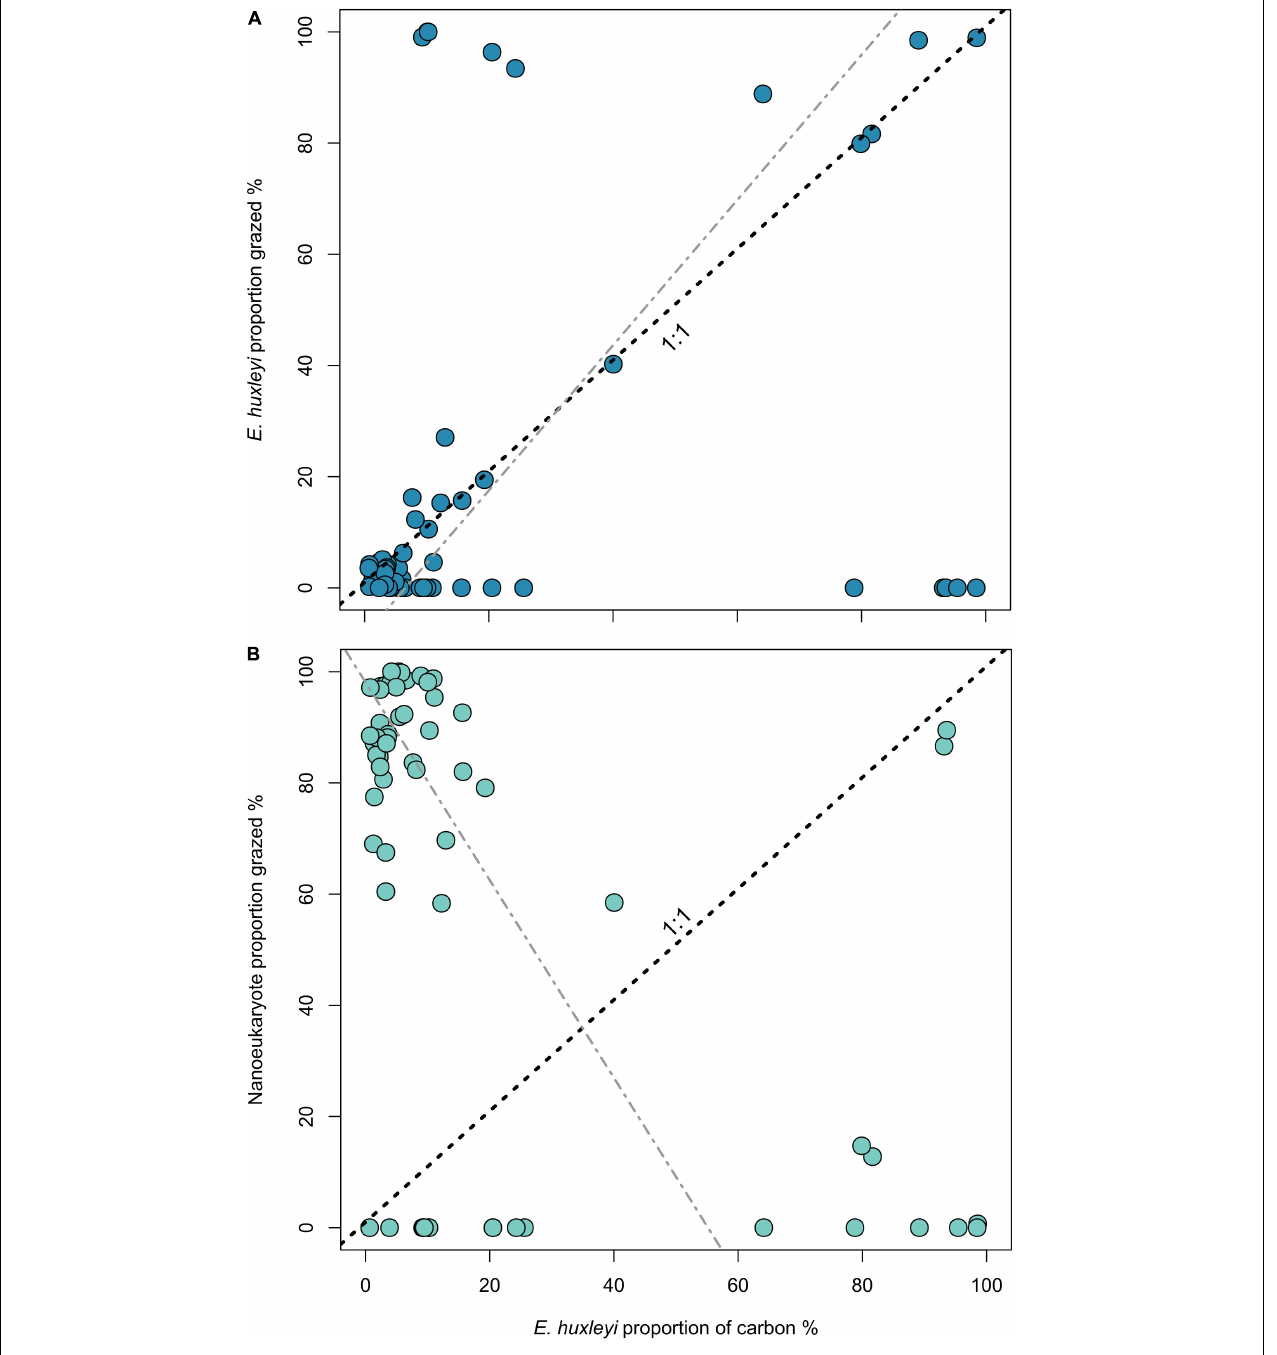
FIGURE 3 | Proportion of E. huxleyi within the community (estimated from flow cytometry counts) against the proportion of E. huxleyi carbon consumed (A) and nanoeukaryote carbon consumed (B) . Dashed line indicates the 1:1 line and gray line displays the Model II regression by reduced major axis. For (A) line equation is y = –8.57 + 1.31x, r 2 = 0.14, and for (B) y = 98.09 – 1.78x, r 2 = 0.24, for both p < 0.01.